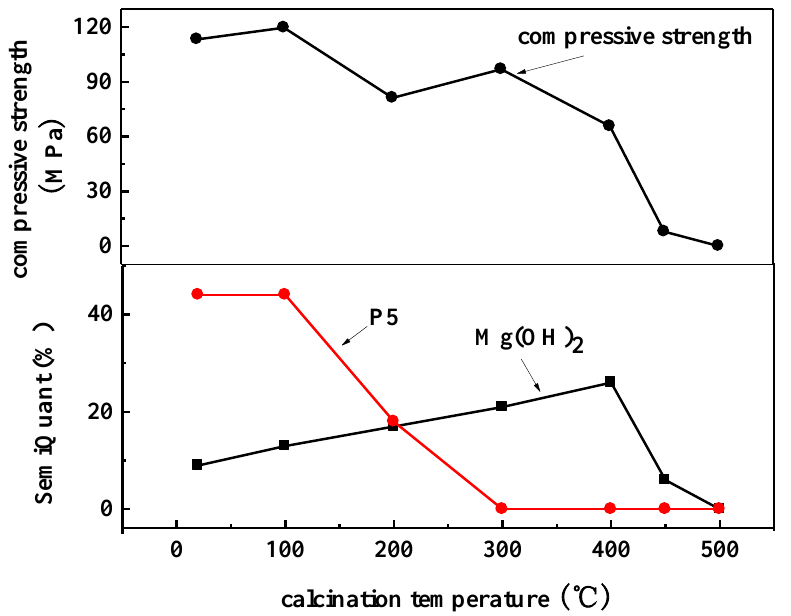
Figure 6. Relationship between compressive strength and P5 and Mg(OH) 2 contents of MOC pre- pared using different calcination temperatures; the semiquantitive P5 and Mg(OH) 2 contents (lower panel) are obtained from an analysis of the XRD spectra by using Topas 4.2 software.